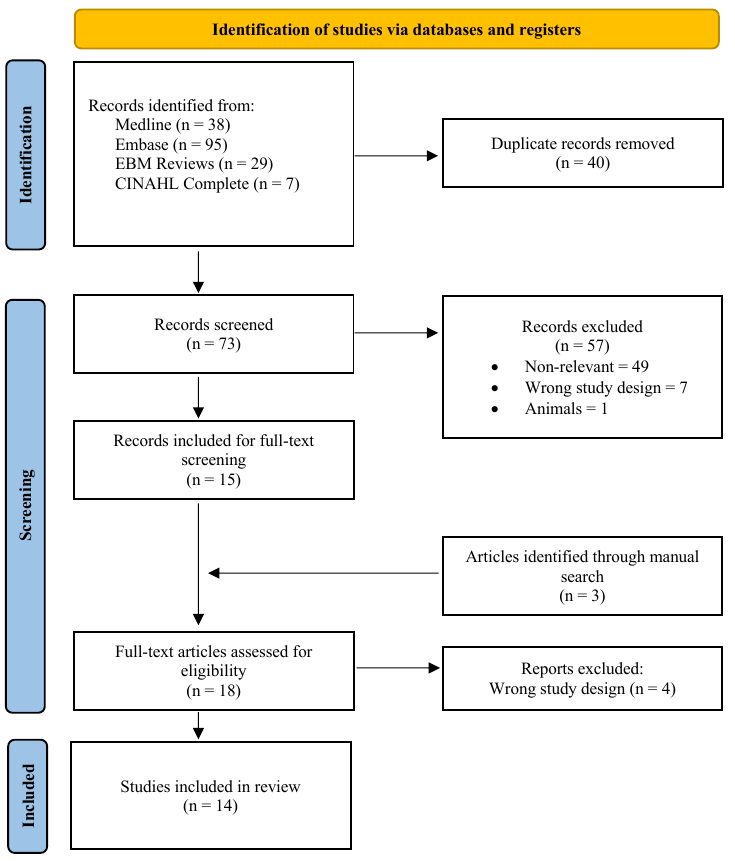
Figure 2. PRISMA flow